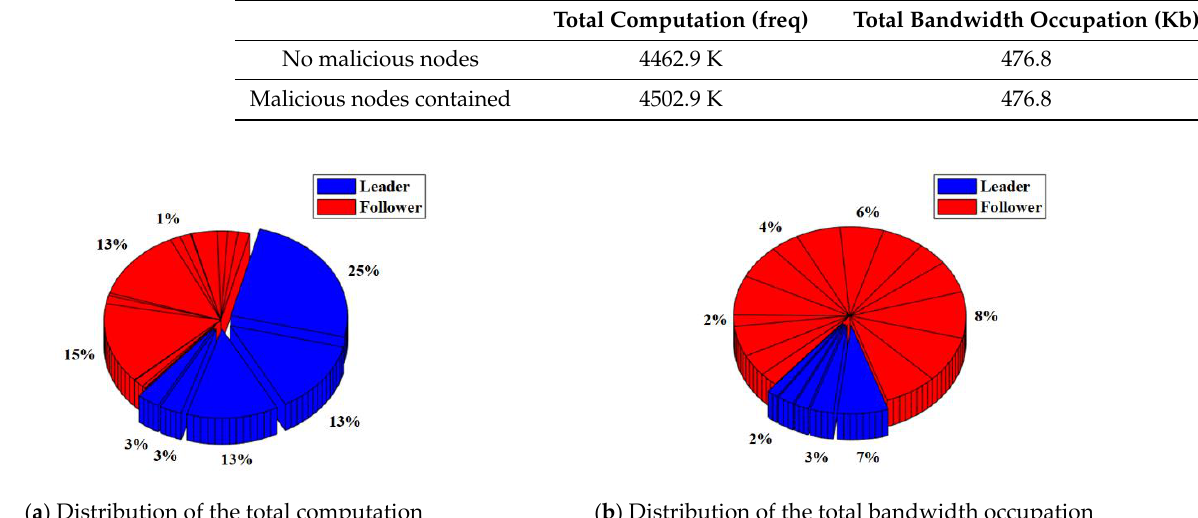
Figure 14. Resource occupation of the DPOS algorithm with no malicious nodes.